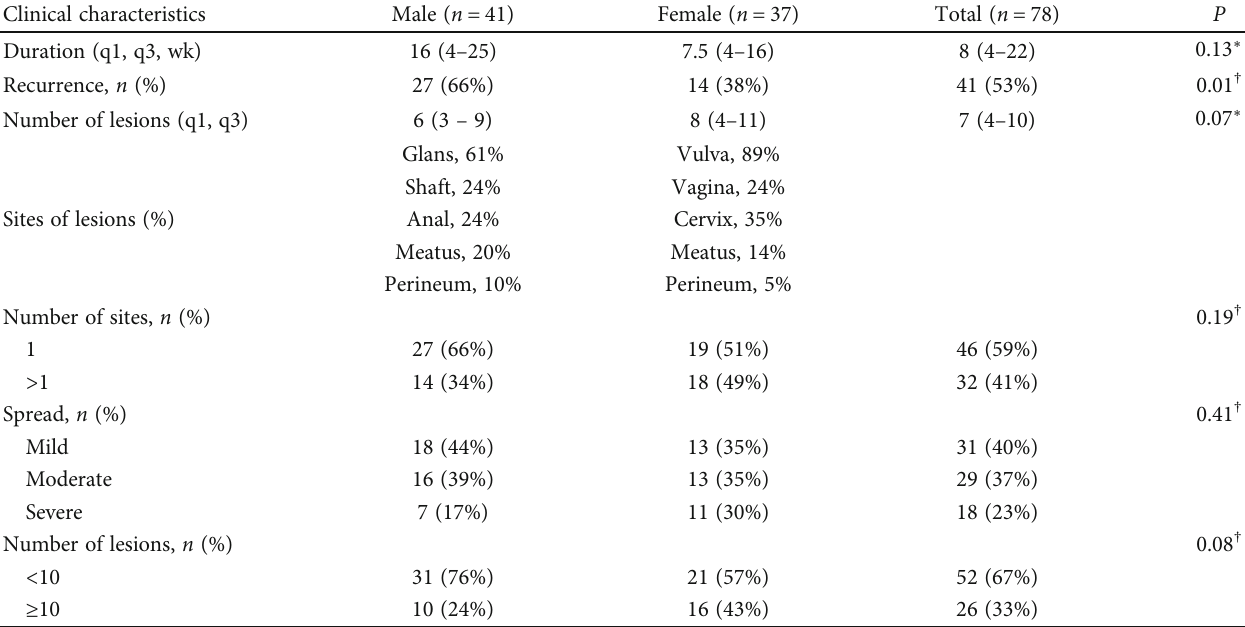
Table 1: The clinical characteristics of patients with genital warts. Clinical